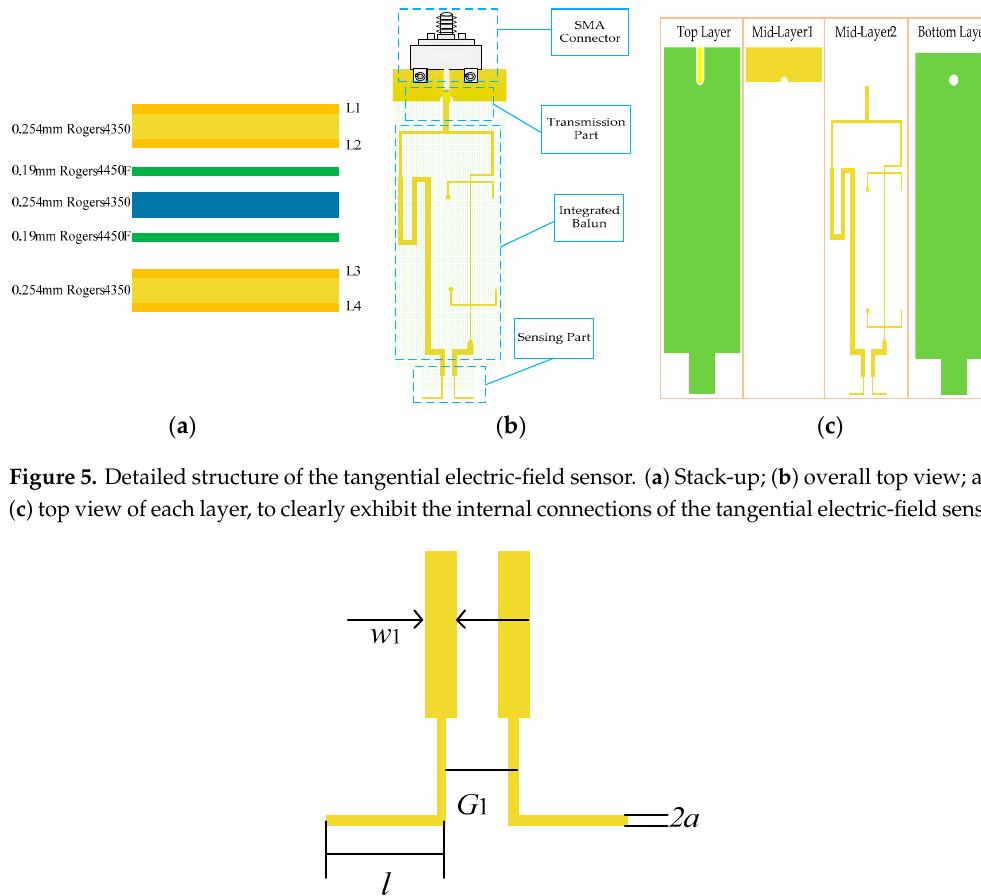
Figure 6. Electric dipole used as the sensing part of the tangential electric-field sensor. l = 4 mm. G 1 = 0.65 mm. w 1 = 0.35 mm. a = 0.05 mm.